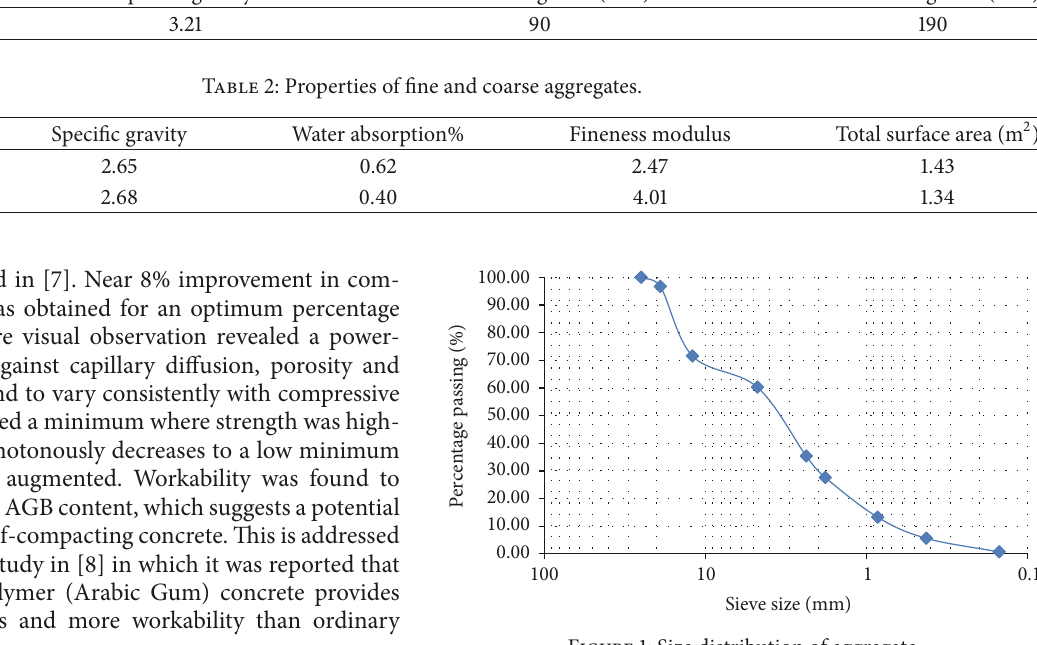
Figure 1: Size distribution of